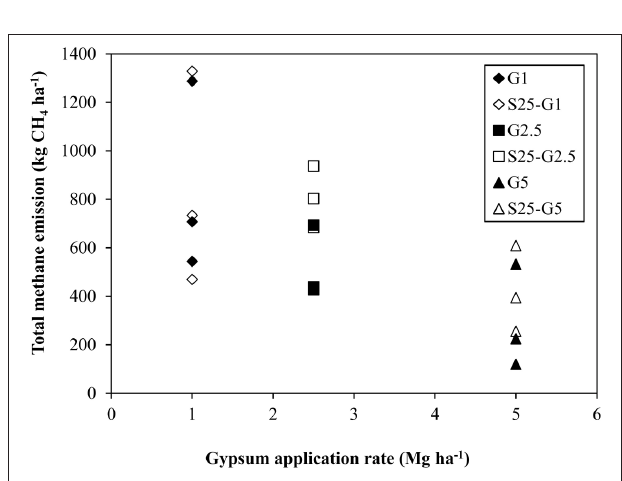
FIGURE 6 | Relationship between total CH 4 emission and gypsum application rates. ** Stands for significance at p =